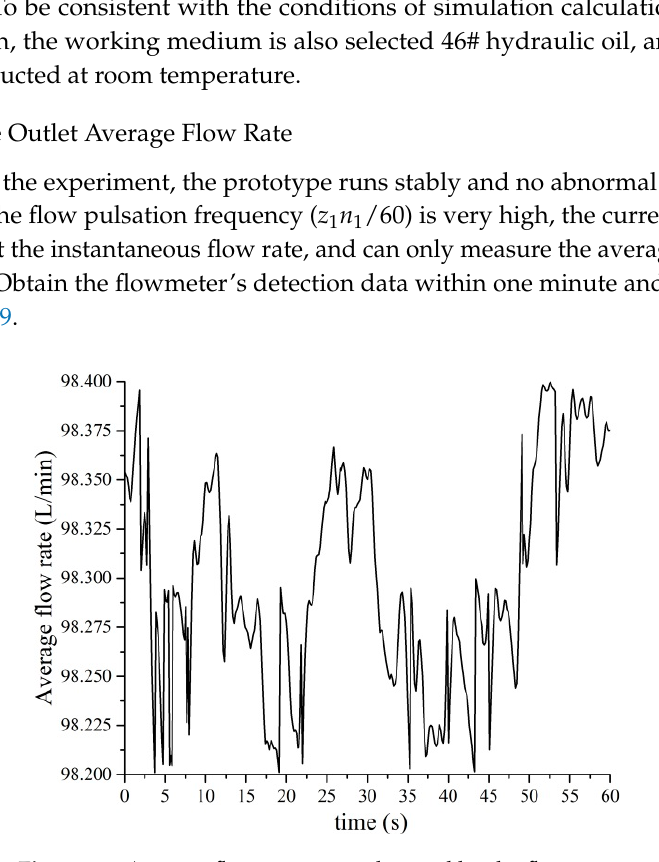
Figure 19. Average flow rate curve detected by the flowmeter.